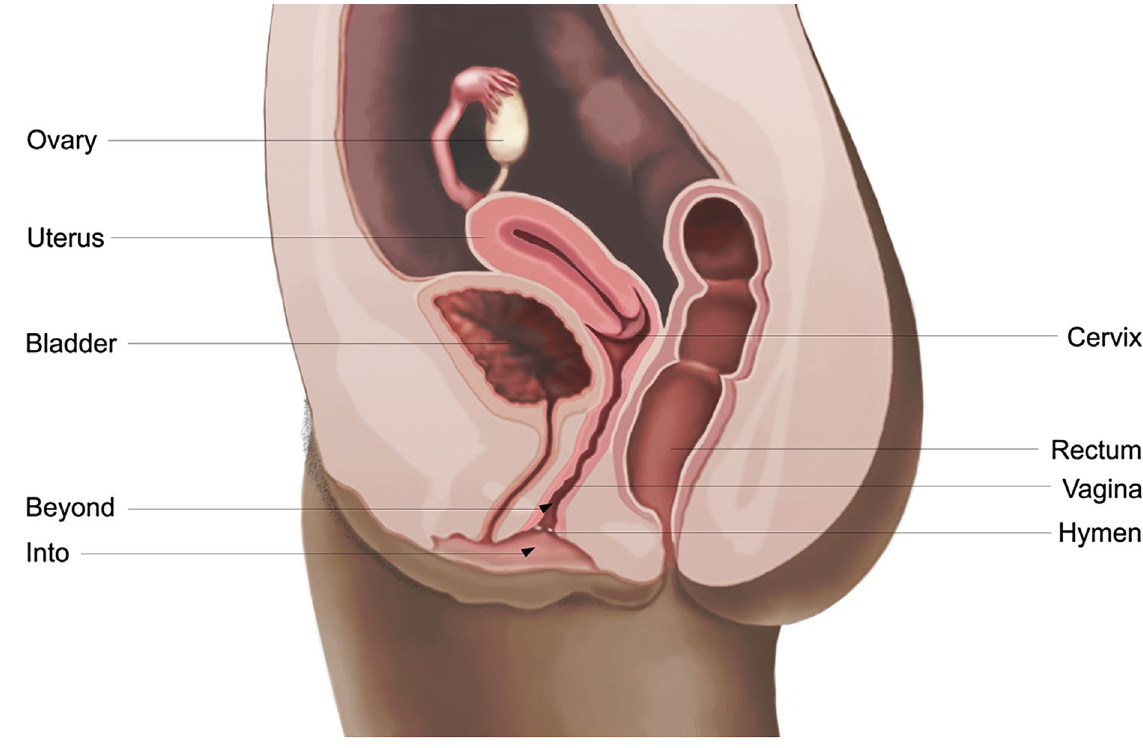
Figure 1: Diagrammatic explanation for penetration to any extent whatsoever into or beyond the female